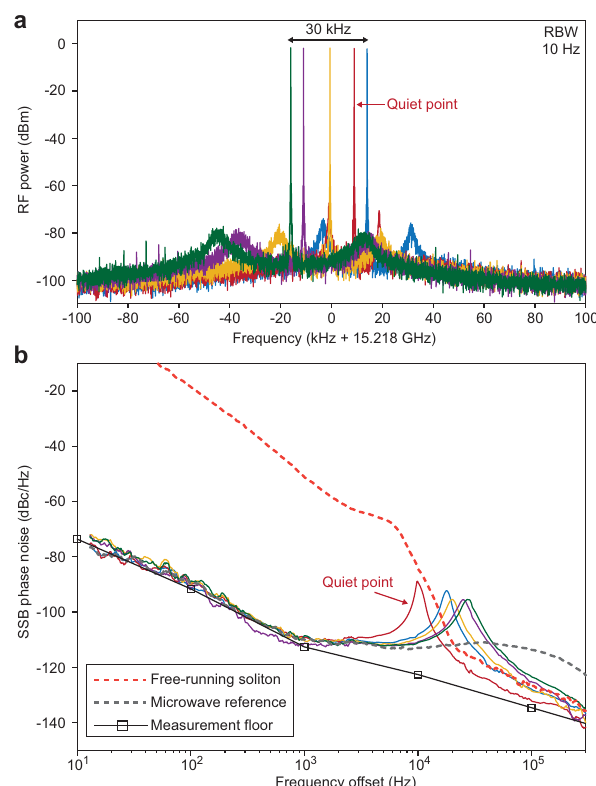
Fig. 6 Soliton repetition rate disciplined to an external microwave source. a Electrical beatnote of locked soliton repetition rate showing fi ne tuning control of the repetition rate. The resolution bandwidth (RBW) is 10 Hz. b Phase noise of free-running (dashed red line) and disciplined soliton microcomb (indicated by color in accordance with panel a ). The trace measured near the quiet point is indicated. The phase noise of the microwave reference source is also displayed (gray dashed line).